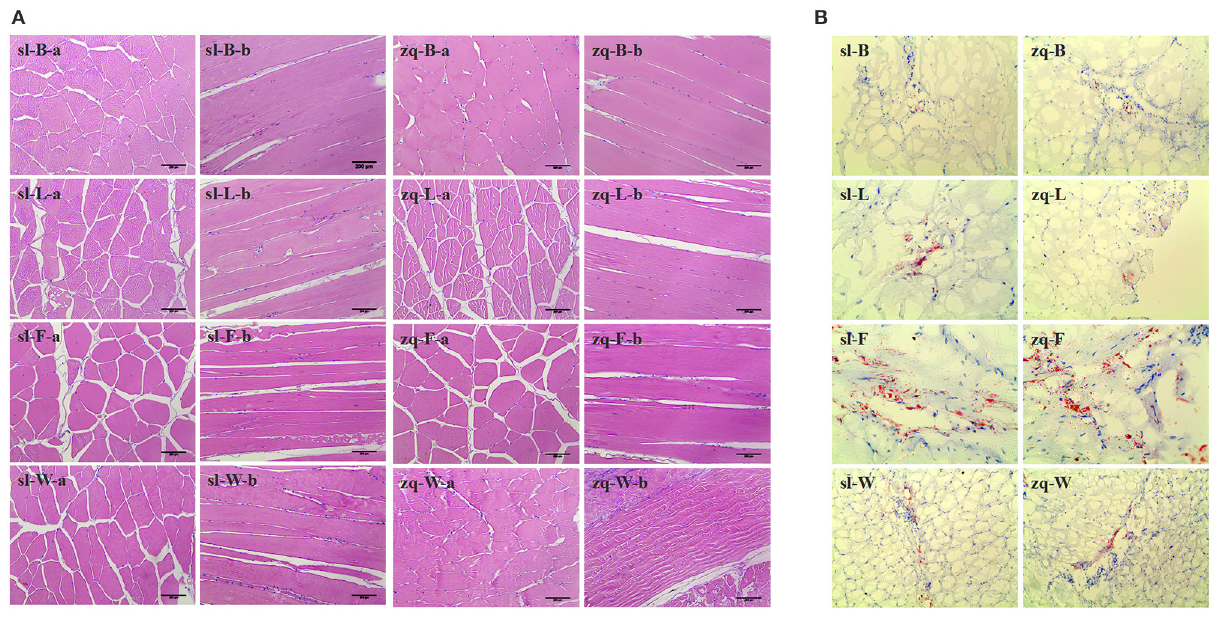
FIGURE 3 | Tissue sections of different positional muscle of C. idellus . The different positional muscle samples were collected from artificial feed C. idellus (sl) and grass feed C. idellus (zq). Left part (A) , H&E staining (original